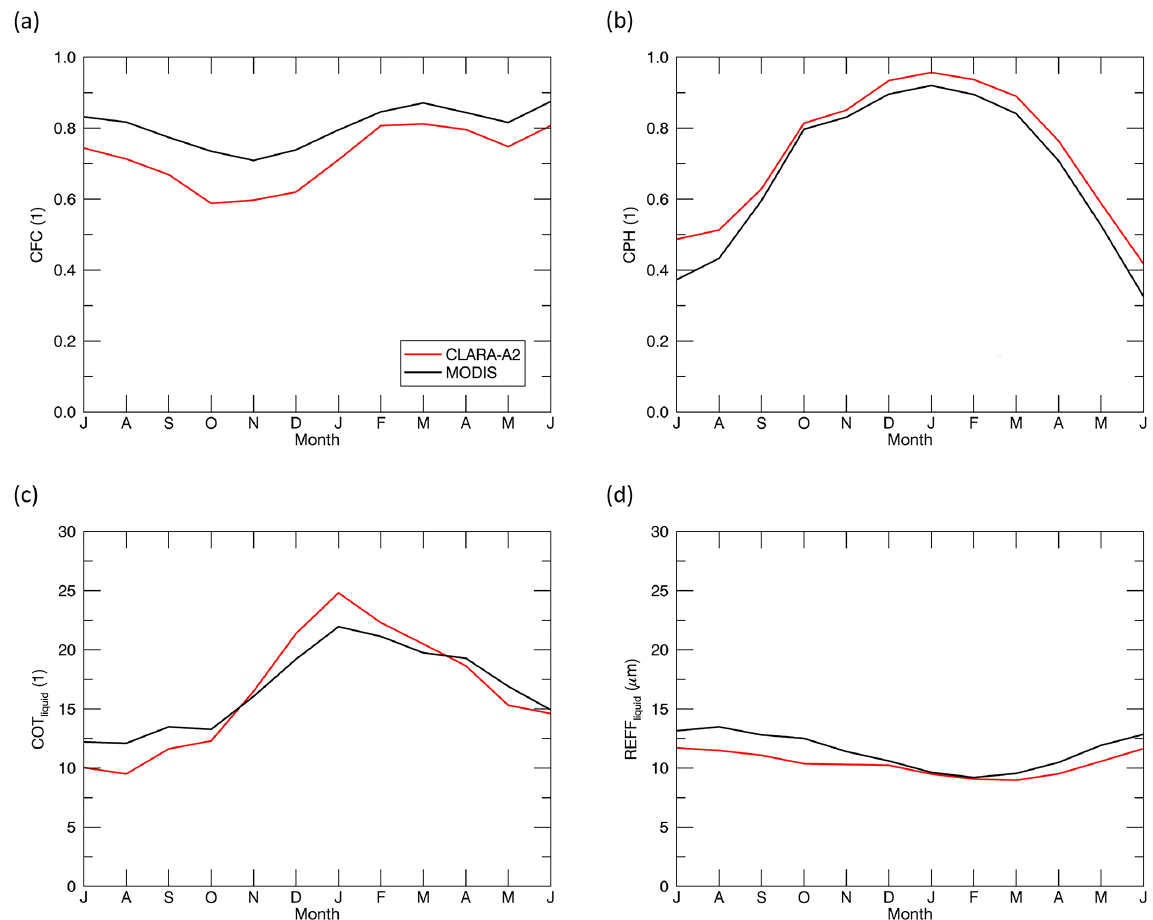
Figure 7. Seasonal variations in cloud properties over southern China, based on CLARA-A2 and MODIS data, during the period 2006–2015. (a) Total CFC, (b) cloud phase (CPH; fraction of liquid clouds relative to total CFC), (c) COT for liquid clouds and (d) REFF for liquid